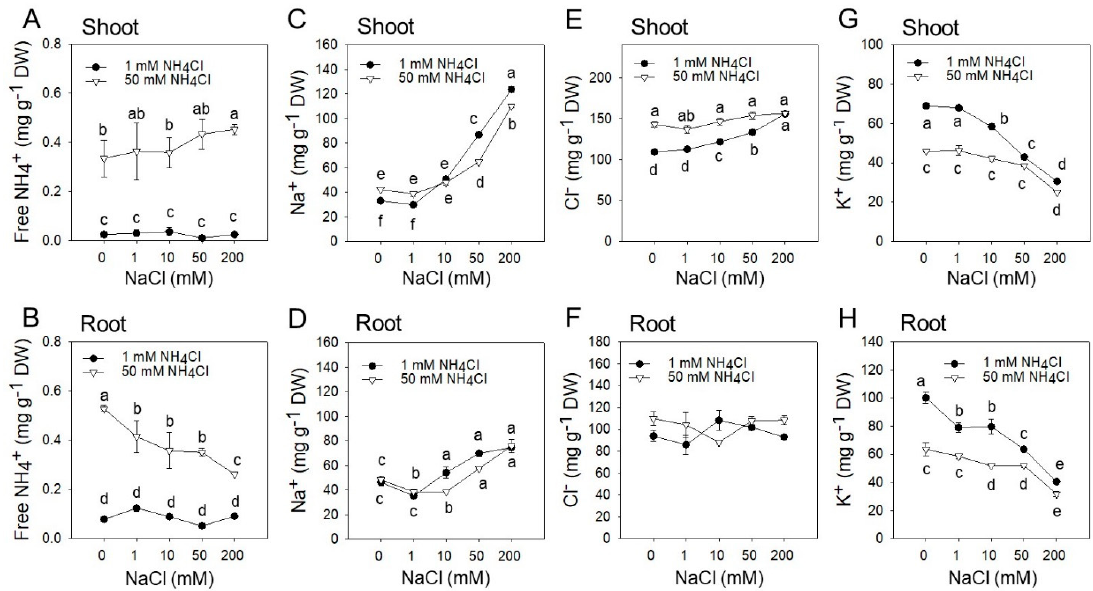
Figure 3. Ion content of shoots (top panel, A - C - E - G ) and roots (bottom panel, B - D - F - H ) of S. europaea in response to five NaCl concentrations (0, 1, 10, 50, 200 mM) in combination with two NH 4 Cl concentrations (1 and 50 mM). Means with the same letter are not significantly different according to the Duncan’s test ( p < 0.05). Error bars represent the standard error.